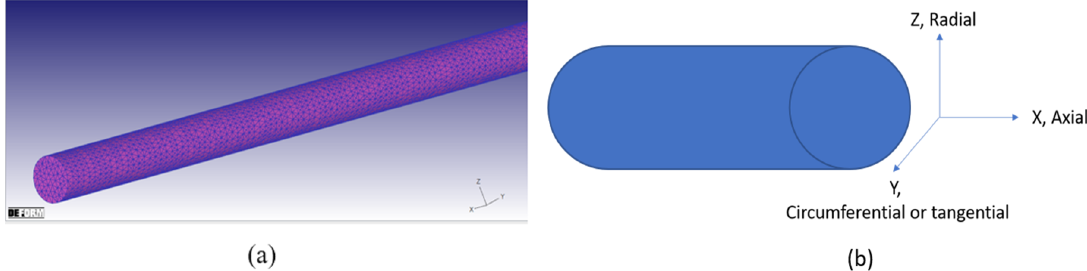
Figure 2. ( a ) The mesh domain of the work piece, and ( b ) axial (X), circumferential (Y) and radial (Z) directions are shown in Zr-4 swaged rod samples.